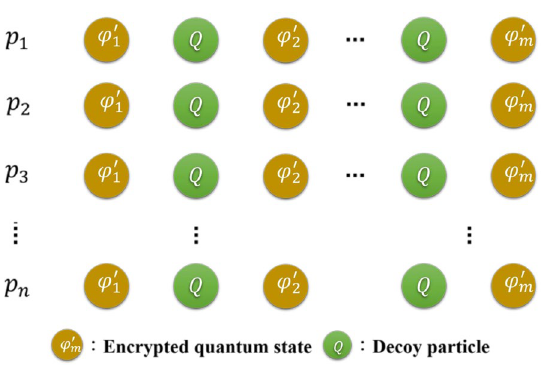
Figure 4. Schematic diagram of the encrypted quantum state and decoy particles.